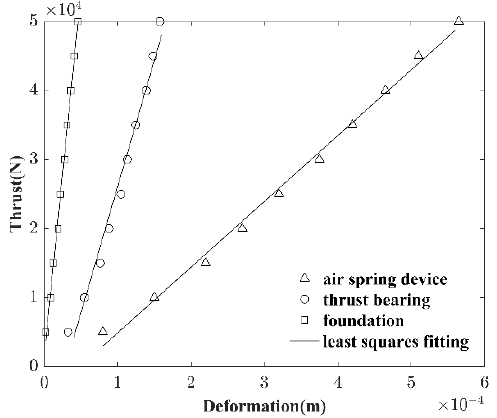
Figure 11. Deformations under the action of different thrusts.